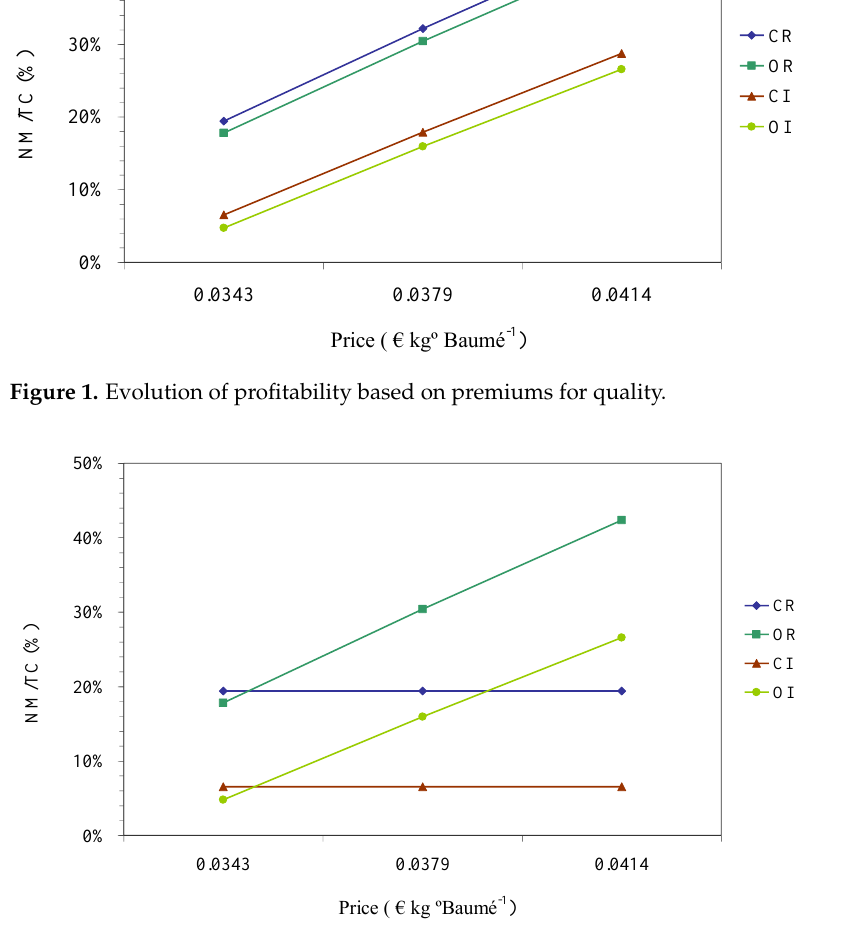
Figure 2. Evolution of profitability based on premiums for organic management.